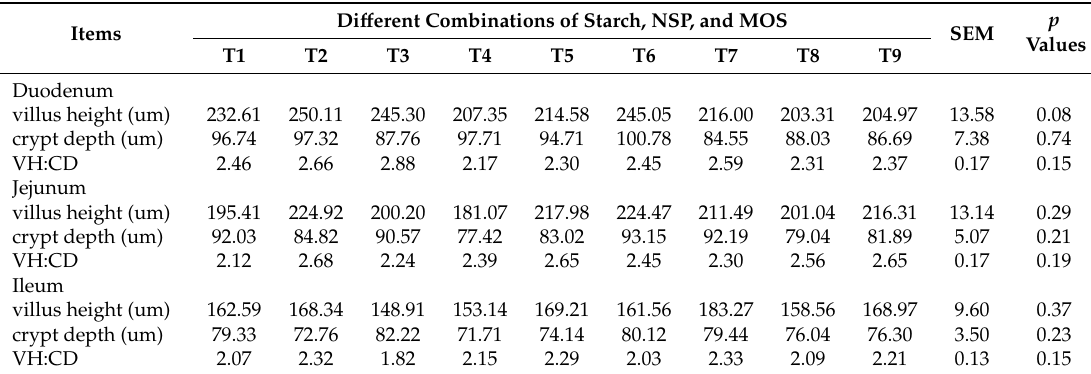
Table 9. E ff ects of di ff erent combinations of starch, NSP, and MOS on the intestinal morphology of weaned